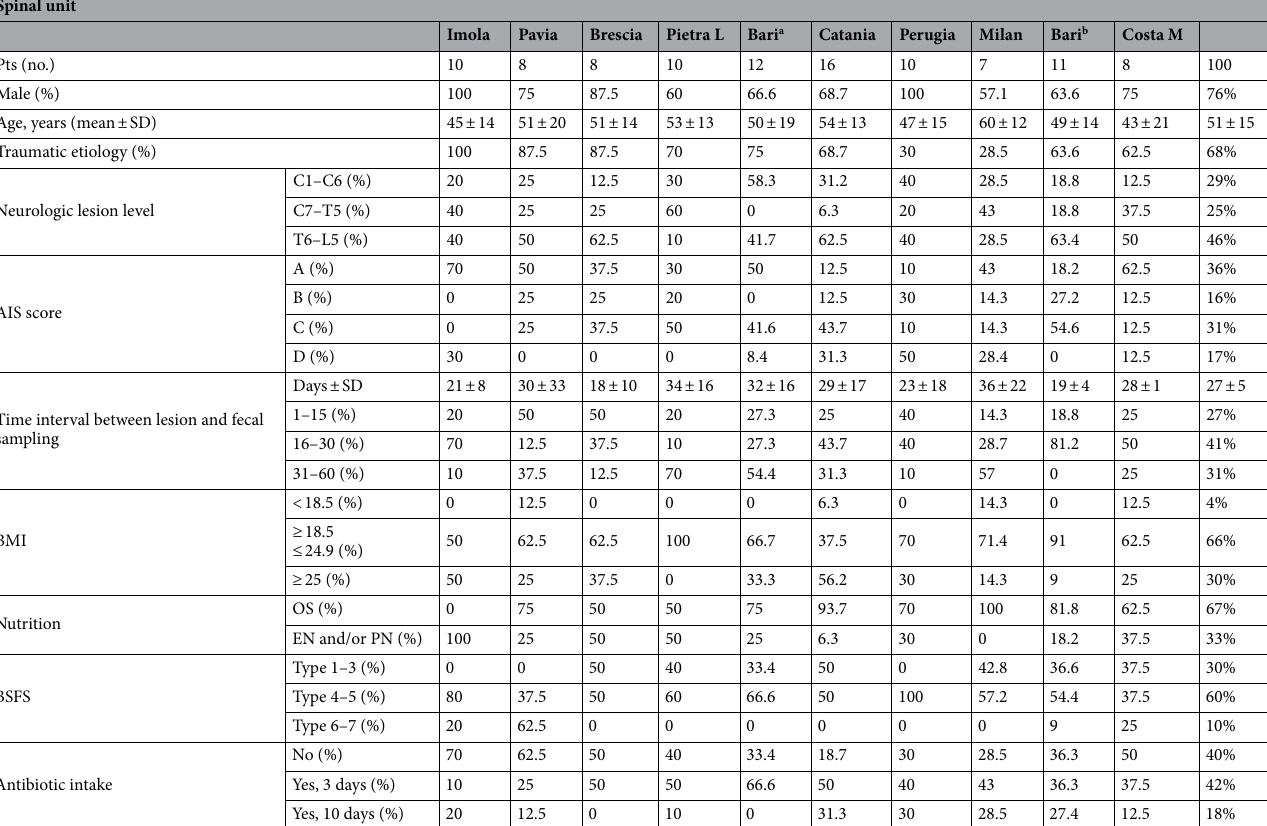
Table 1. Demographic, neurological, anthropometric and clinical characteristics of the 100 enrolled Italian patients with SCI. As for the time interval between lesion and fecal sampling, patients were grouped into the following categories: ≤ 15 days, between 16 and 30 days, and between 31 and 60 days. As for BMI, patients were divided into the following categories: underweight (BMI < 18.5 kg/m 2 ), normal weight (BMI between 18.5